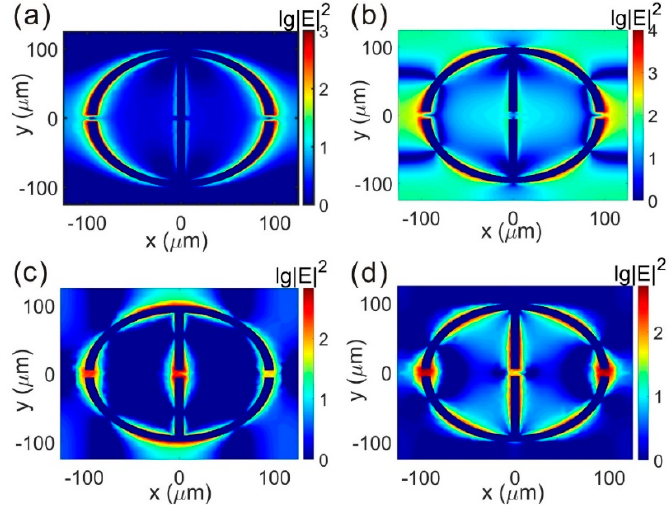
Figure 3. Electric field distributions of ( a ) f = 0.428 THz of TM incidence; ( b ) f = 0.92 THz of TM incidence; ( c ) f = 0.857 THz of TE incidence; ( d ) f = 1.005 THz of TE incidence.